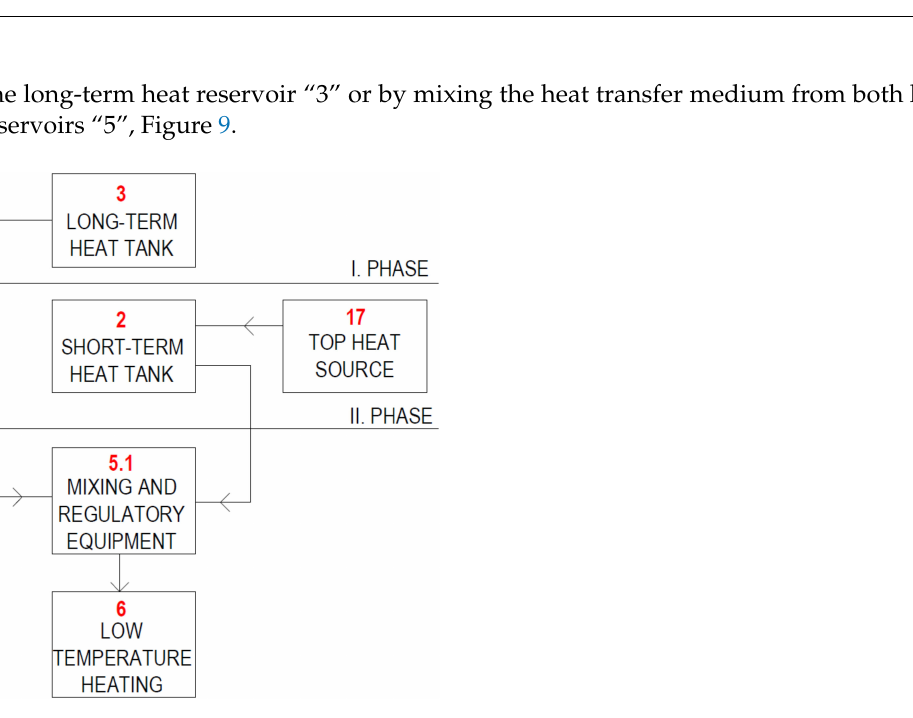
Figure 9. Functional diagram of the combined building-energy system in low-temperature heating mode [17].